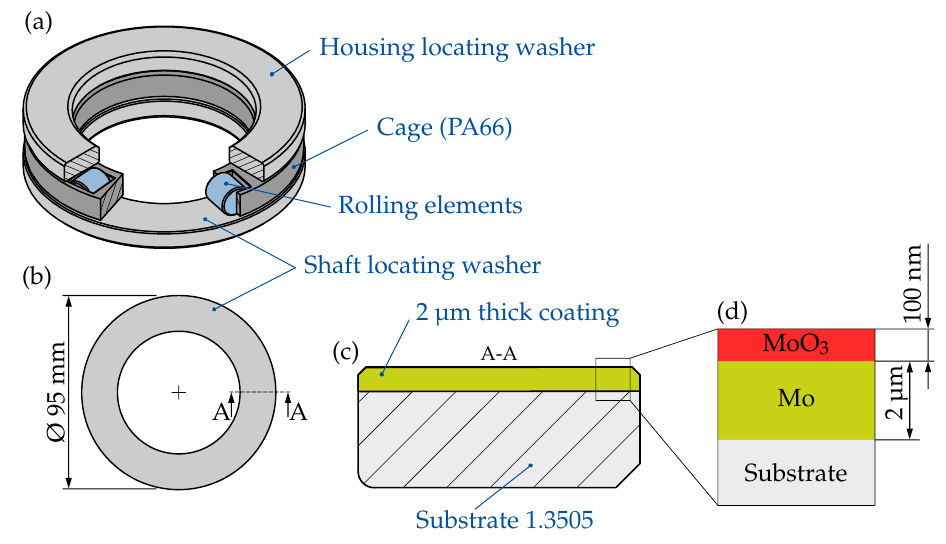
Figure 1. Overview of the prepared specimen. ( a ) Cylindrical roller thrust bearing 81212. ( b ) Top view of the coated bearing washer. ( c , d ) Cross-sectional view of the coating system (not to